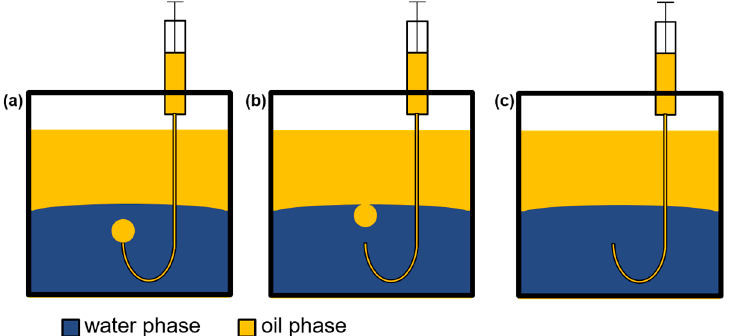
Figure 2. Di ff erent steps in the Di ff usion and Coalescence Time Analyzer (DCTA) measurement setup. ( a ) Droplet is produced at the tip of the capillary. ( b ) Droplet floats to the interface and rests at the highest point. ( c ) Droplet disappears due to coalescence.